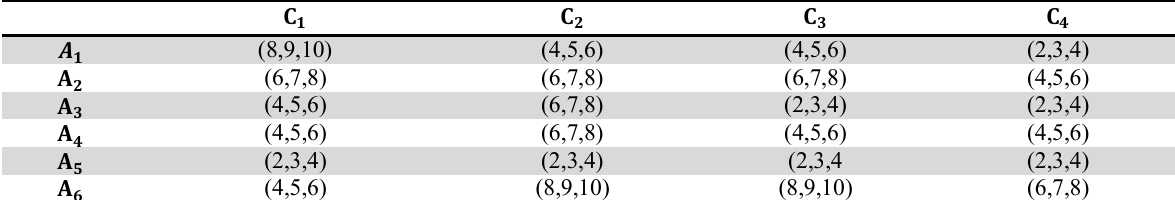
The decision matrix of the problem